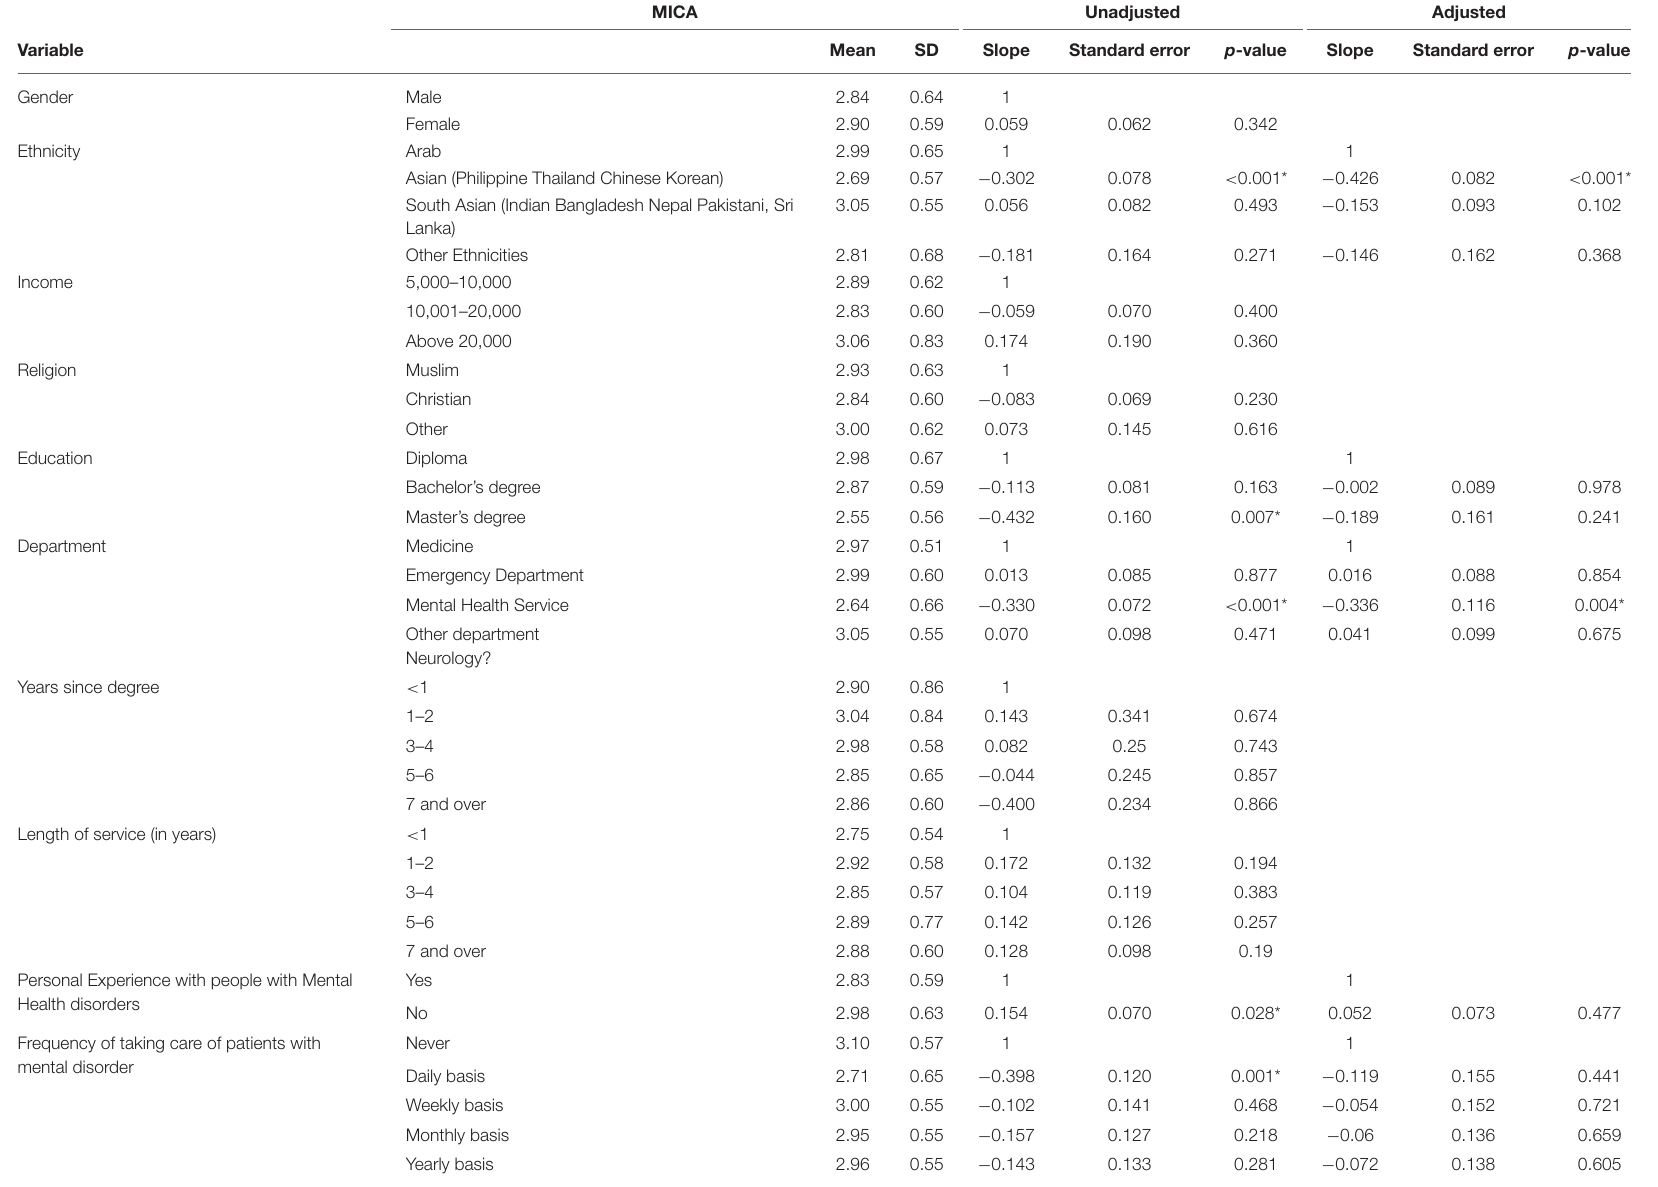
TABLE 3 | Association between MICA scores and nurses’